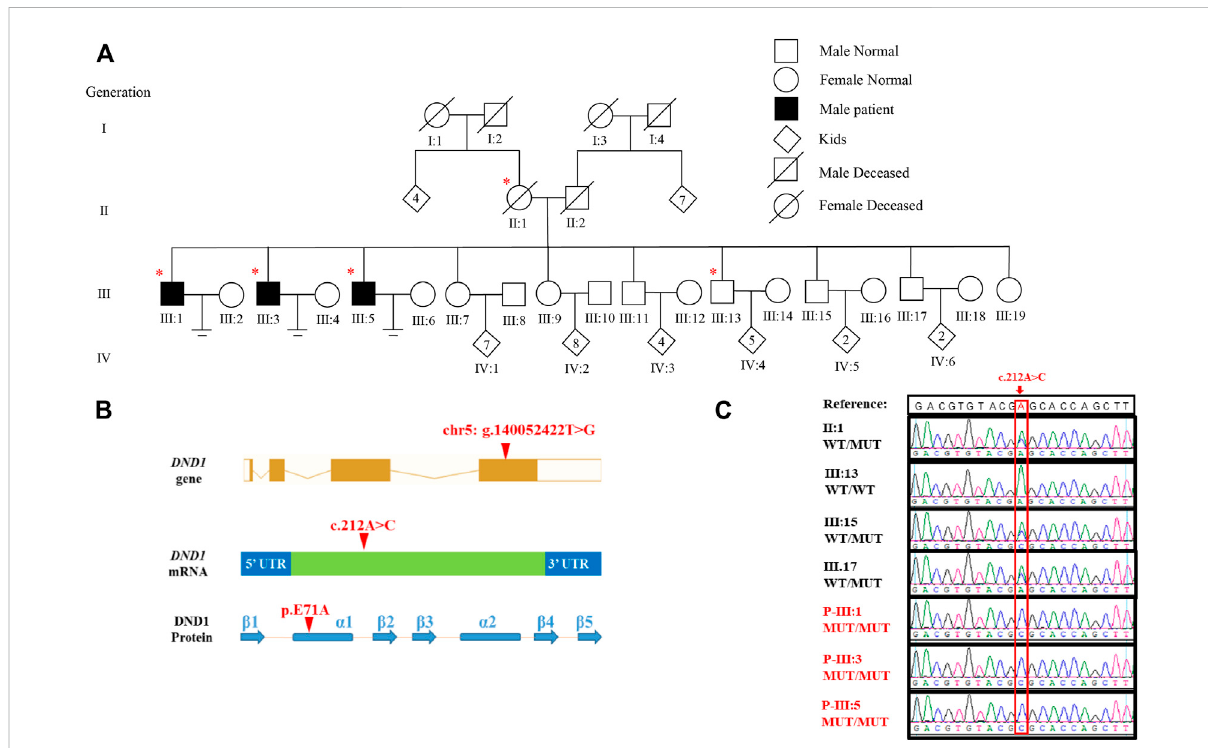
FIGURE 1 Identi fi cationofDND1E71AMutationinthreepatientswithazoospermia. (A) Pedigreeoftheaffectedfamily.Circlesandsquaresdenotefemales and males, respectively. Deceased family members are denoted by slash symbols. Individuals marked with asterisks, undergone whole exome sequencing. (B) Location of the identi fi ed variant in DND1 at both cDNA and protein levels. The mutation site was located in α -subunit of RBD1. (C) Chromatograms of con fi rming DND1 mutation site by Sanger sequencing. WT, wild-type allele. MT, mutant allele. A, adenine; C, cytosine; G, guanine; T,